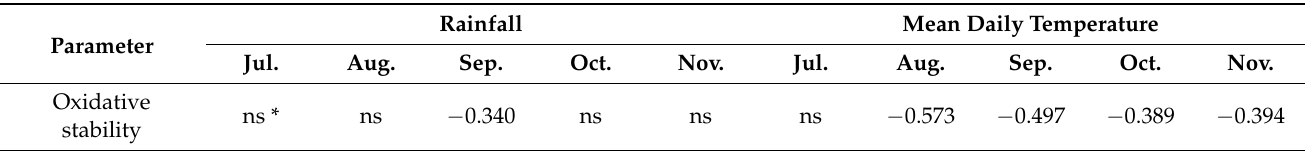
Table 4. Correlation factors of virgin olive oil oxidative stability and climatic parameters (rainfall and mean daily temperature; Table S1) in the period of intensive growth and ripening of olive